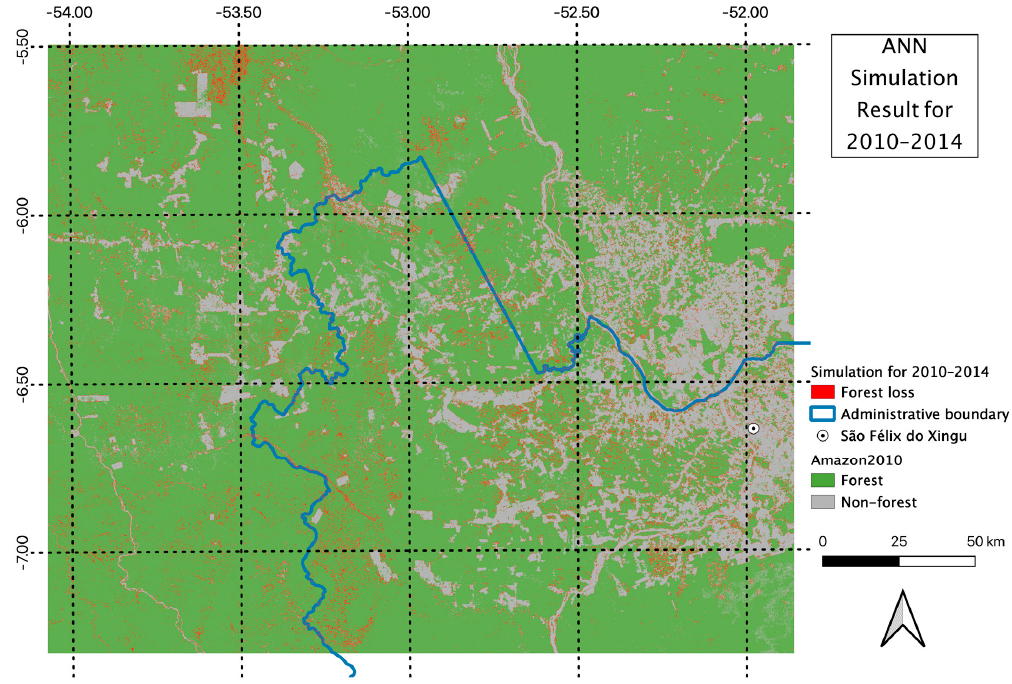
Figure 8. Artificial neural network (ANN) simulation result for the year 2010 to